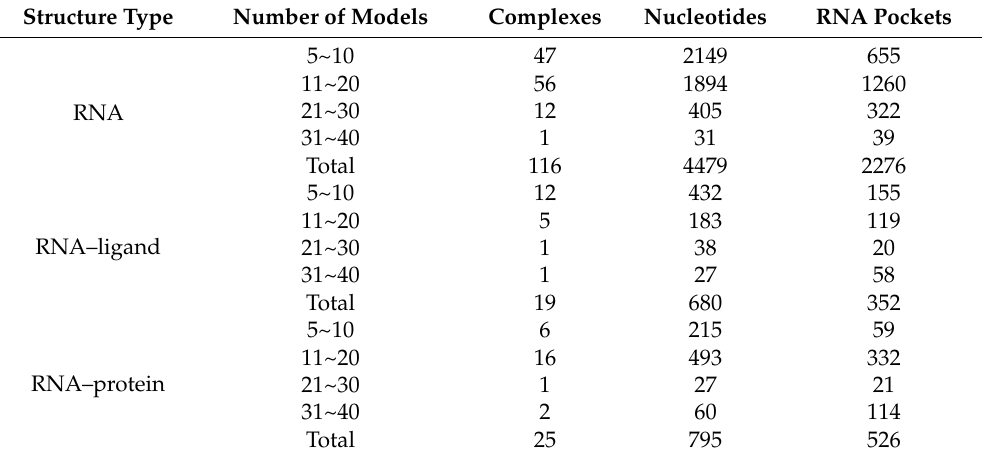
Figure 1. The proportion of various types of RNA and the pocket distribution of each RNA type in RNA ( A ), RNA–ligand ( B ), and RNA–protein ( C ) structures. The inner loop is the proportion of various types of RNA. The outer loop is the maximum number of pockets contained in structural models of a complex. Table 1. Summary of RNA dataset based on the number of structural